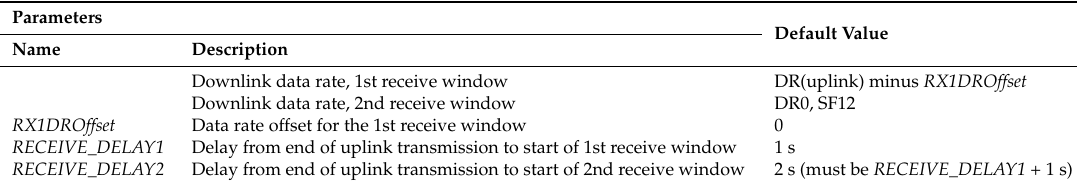
Table 4. Basic physical layer parameters and their default values.